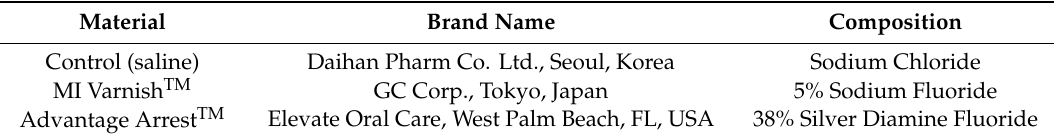
Table 1. Materials used in this